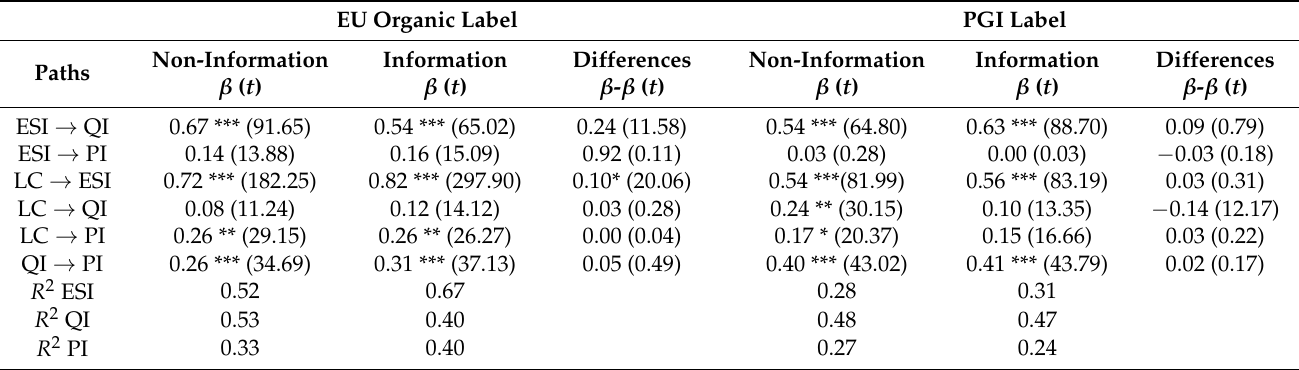
Table 3. Multigroup comparison.